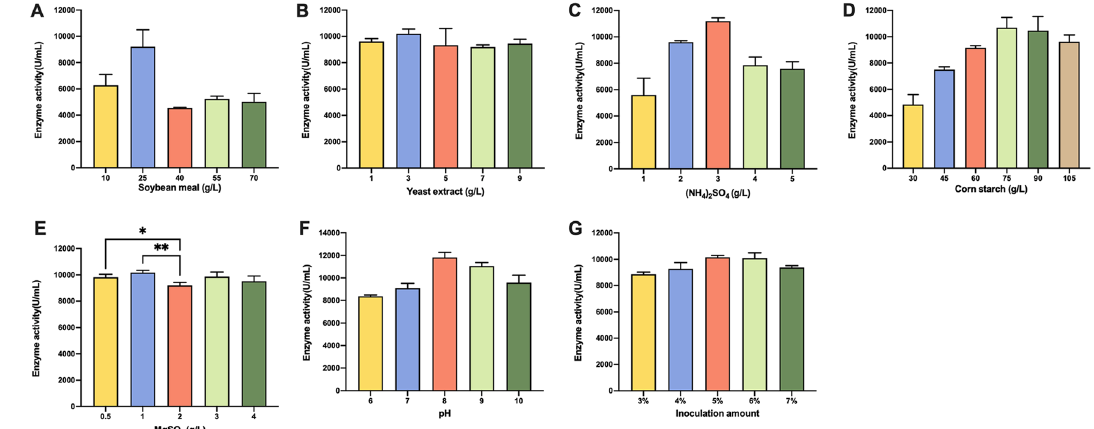
Fig. 2 Effect of different nitrogen sources on alkaline protease